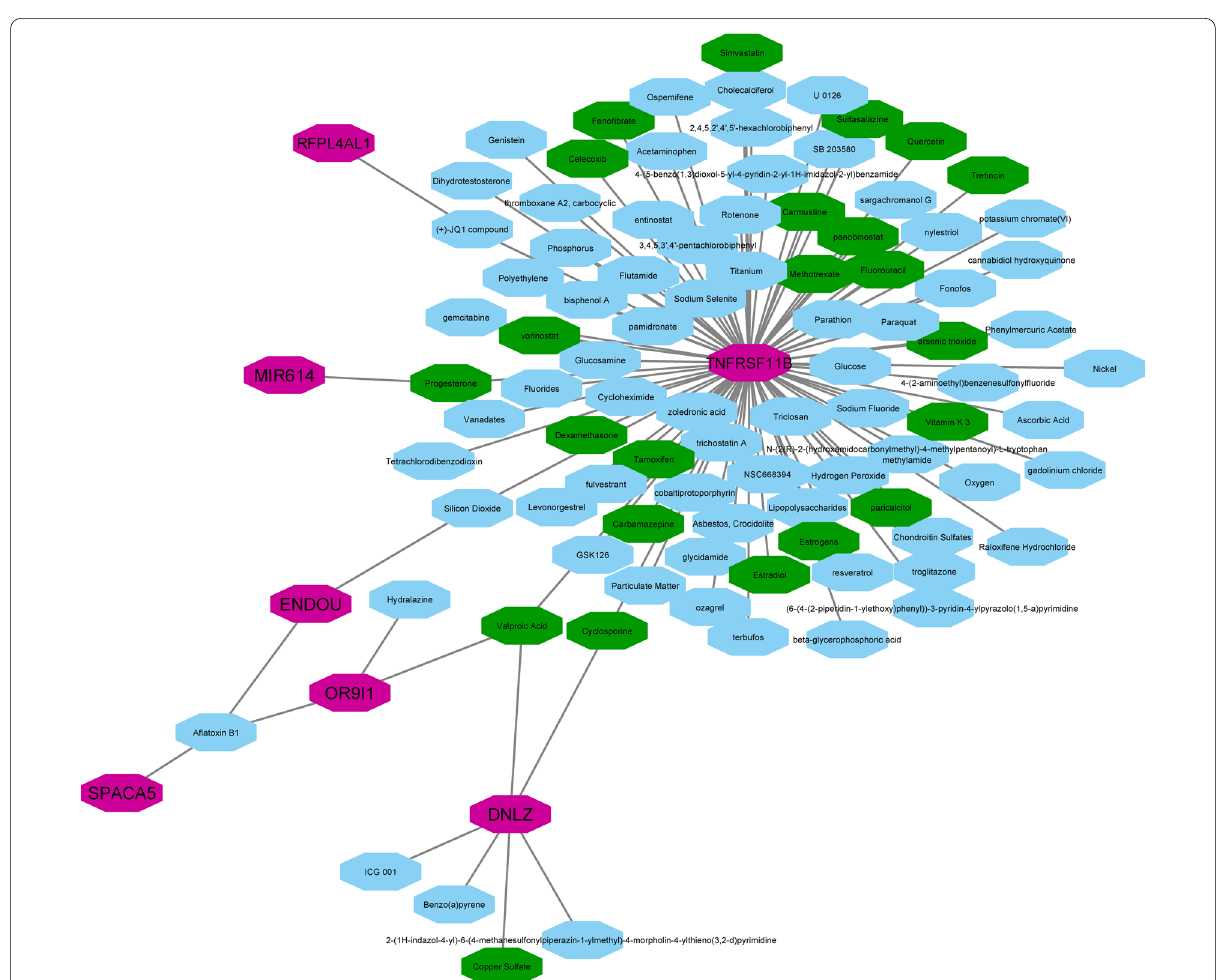
Fig. 4 The gene–chemicals association network illustrating compounds directly connected with chemicals for skin-related disorders in green color. The involved genes are shown in